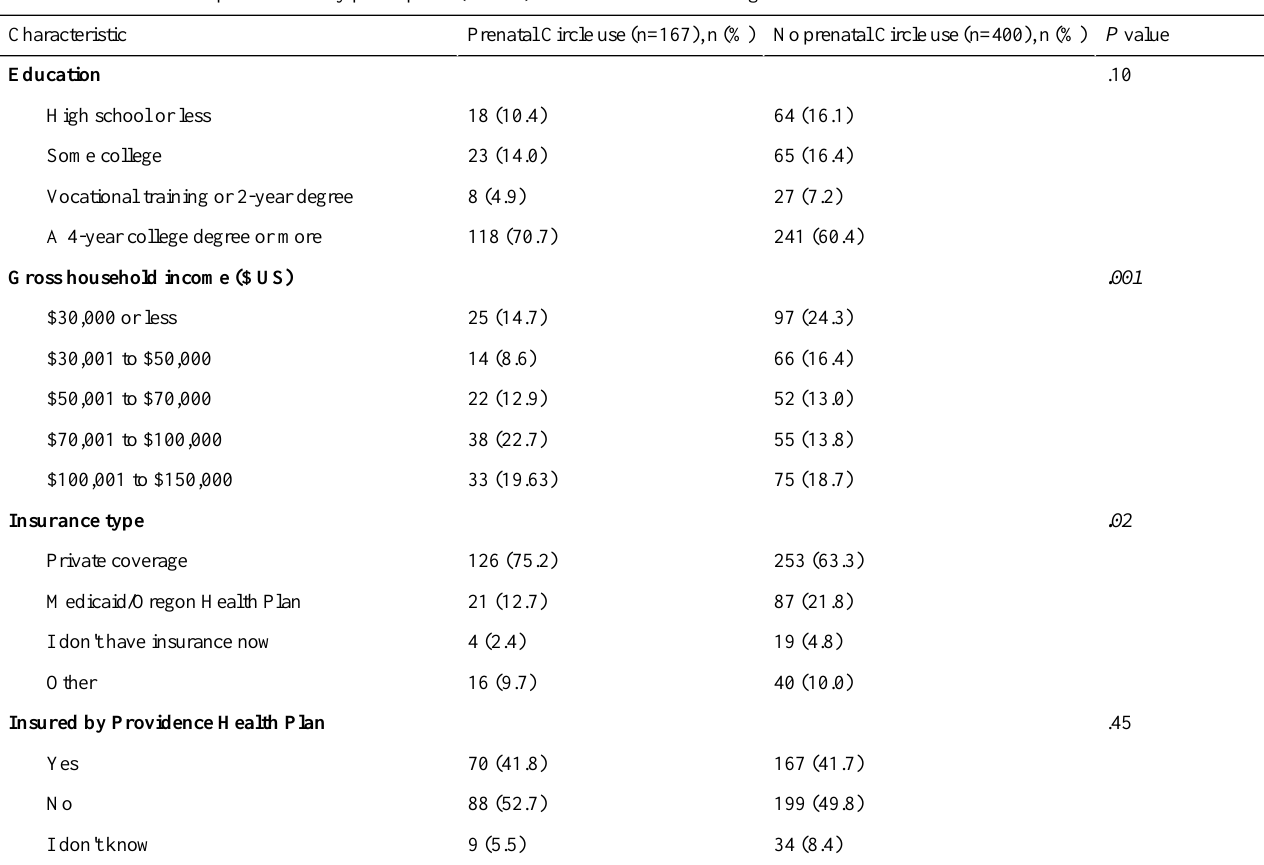
Table 2. Socioeconomic profile of study participants (N=567). Italicized P values are